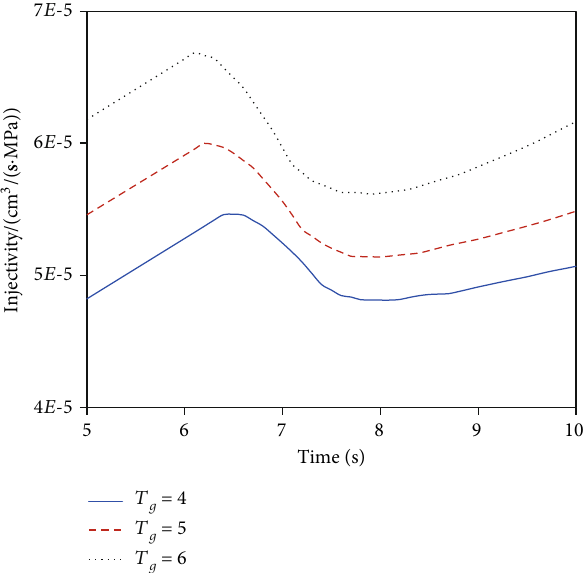
Figure 5: Injectivity change with time for di ff erent oil